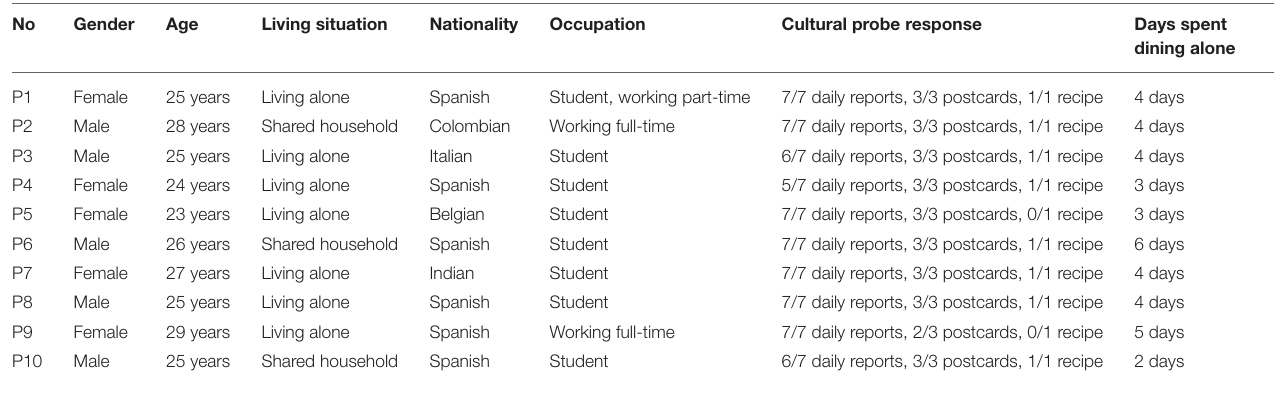
TABLE 2 | Demographic details of participants completing the 7-day cultural probe